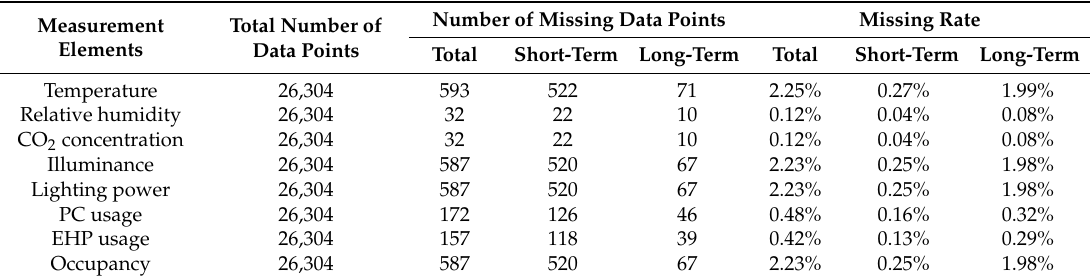
Table 4. Quality analysis of measurement data.